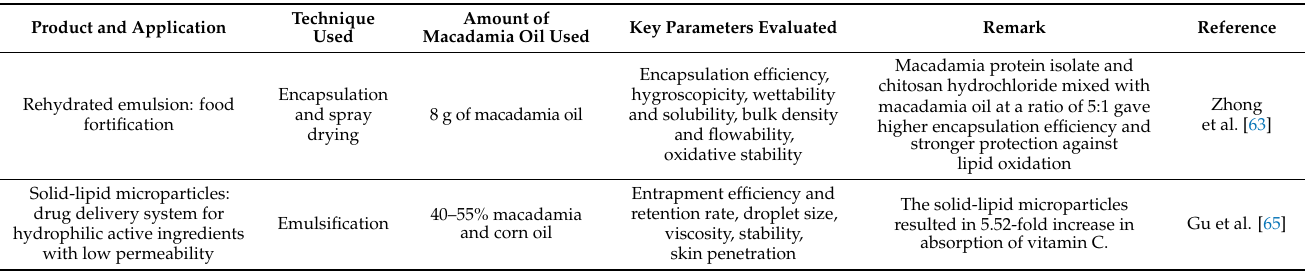
Table 6. Food and non-food applications of cold-pressed macadamia nut